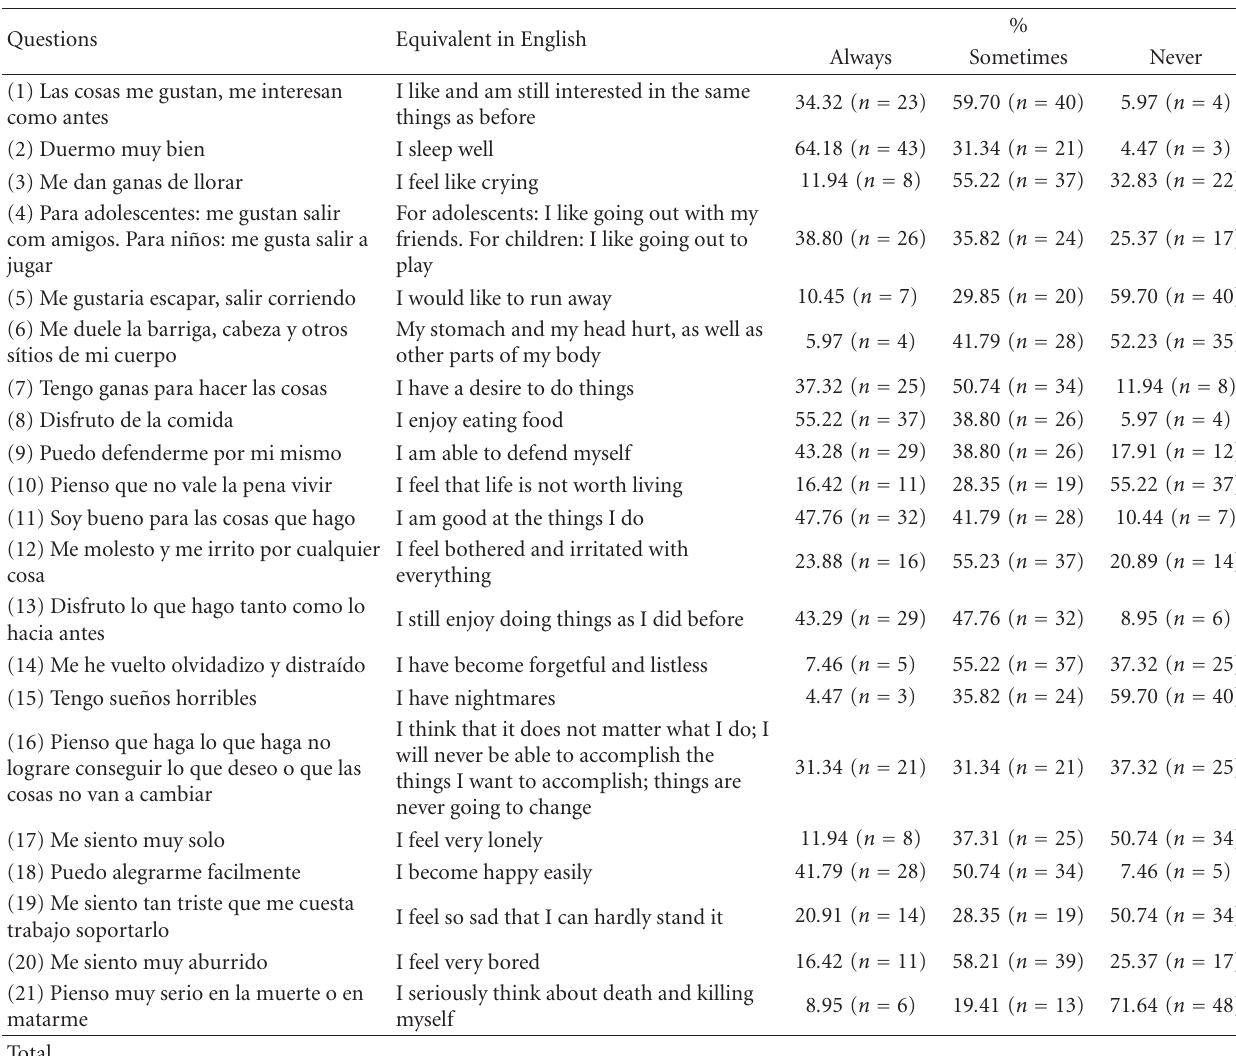
Table 5: Modified Scale of Birleson and frequency of symptoms of the 67 patients; it is presented as an original sample, and it has been literally translated in order to have a better understanding of depressive symptomatology. Always have a score of 2, sometimes of 1, and never of